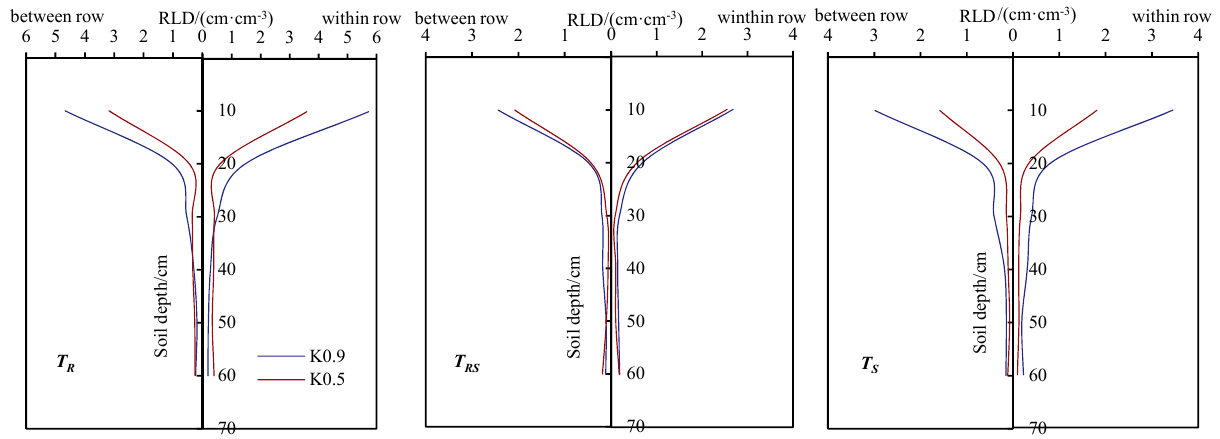
Table 2. Experiential parametric simulation results of the NRLD fit function for greenhouse tomato at the late growth stage under different ventilation and irrigation amounts in 2021.